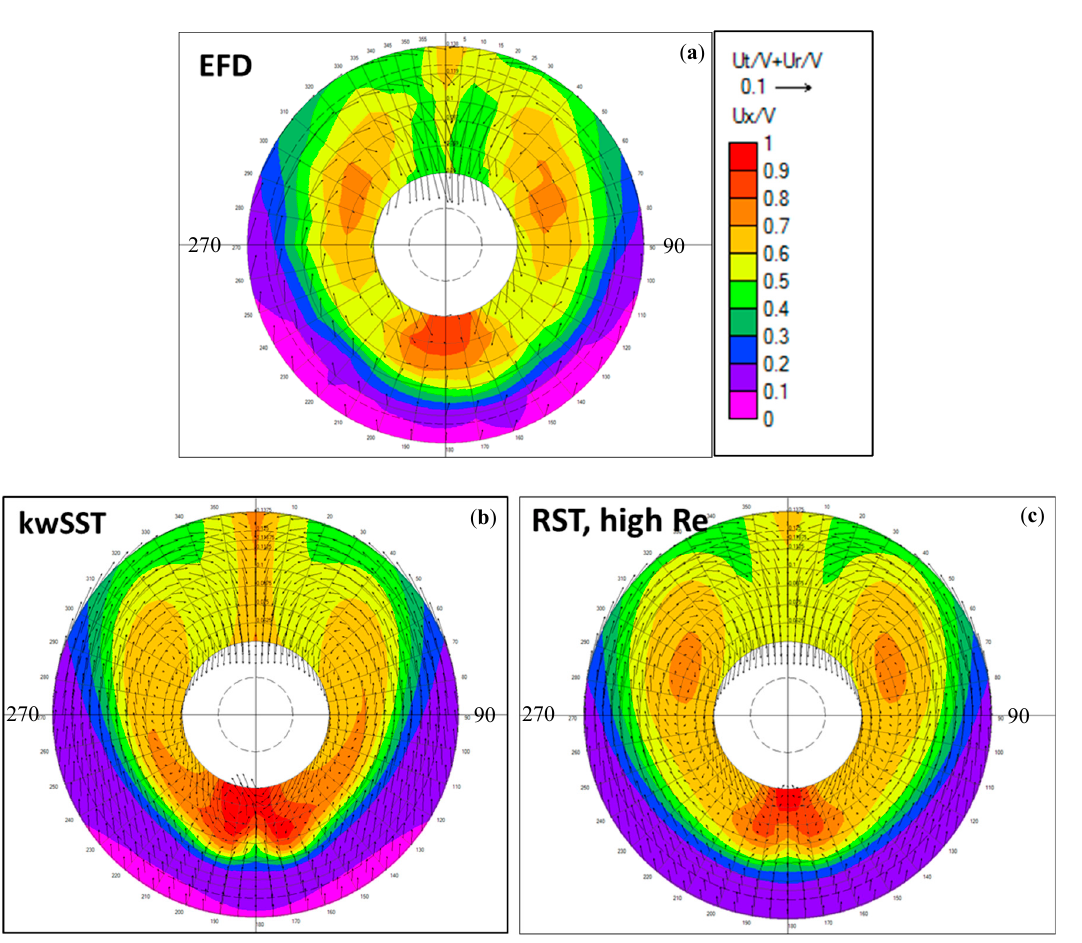
Figure 4. Measured and computed nominal wake field around the ESD location. (Model scale, Vs = 14 kn, without ESD). ( a ) measured results. ( b ) CFD results using kwSST. ( c ) CFD results using RST, high Re.